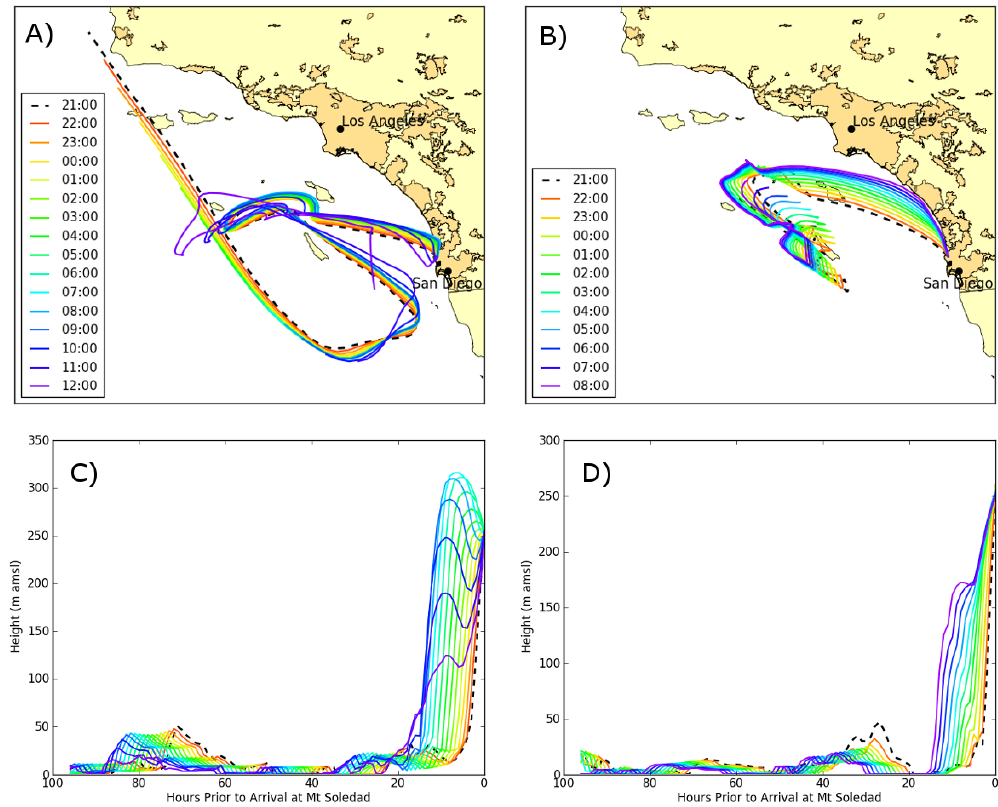
Figure 2. In-cloud HYSPLIT 96h back trajectories ending at hourly intervals for Cloud 2 (12 June 21:00 to 13 June 12:00PDT) in (a) and (c) , and Cloud 3 (17 June 21:00 to 18 June 08:00PDT) in (b) and (d) . All back trajectories started at 10ma.g.l. Darker yellow regions on land in panels (a) and (b) indicate densely developed urban areas containing 50000 or more people (United States Census Bureau). Panels (c) and (d) show the vertical profiles over the same hourly intervals shown in (a) and (b)